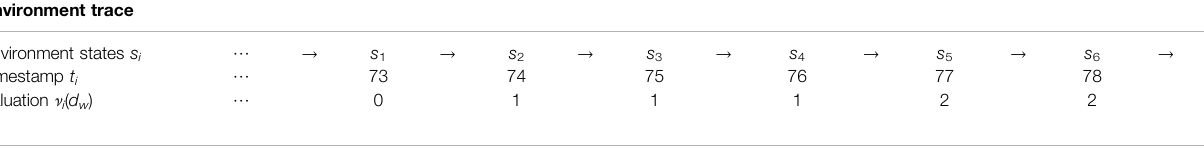
TABLE 1 | Operating environment, event detections and example deferred choice traces for the train ticket scenario. Environment trace Environment states s